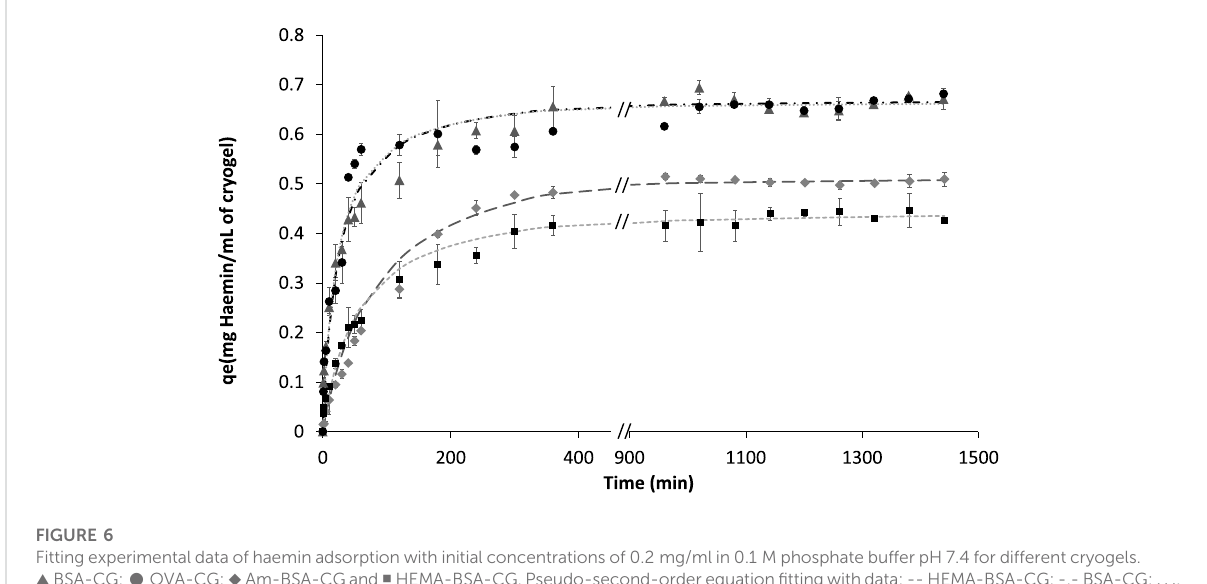
FIGURE 6 Fitting experimental data of haemin adsorption with initial concentrations of 0.2 mg/ml in 0.1 M phosphate buffer pH 7.4 for different cryogels. ▲ BSA-CG; C OVA-CG; ◆ Am-BSA-CGand ■ HEMA-BSA-CG.Pseudo-second-orderequation fi ttingwithdata:--HEMA-BSA-CG;-.-BSA-CG; ... . OVA-CG; _ _ _ Am-BSA-CG; No data available between 400 and 900 min.